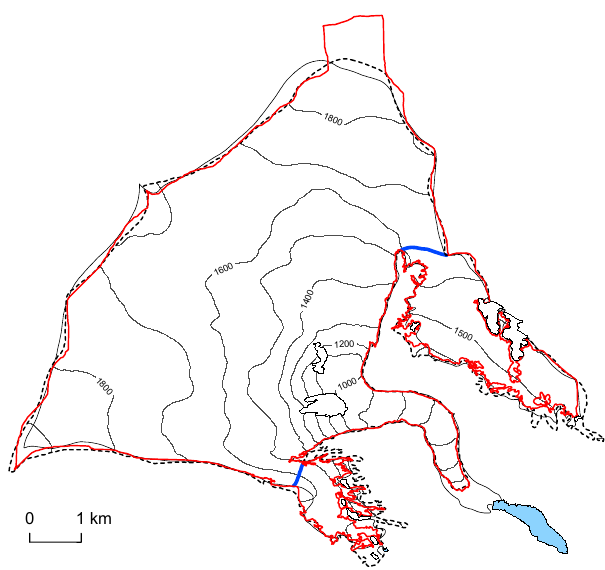
Figure 4. The hydrological basins of Nigardsbreen. The basin is derived from the 2013 mapping in red; the dotted line shows the 1984 extent and basin; the black solid line shows the 1964 extent. The glaciological divides used in the first years are marked in blue. Elevation contours are 100m derived from the 2013 DTM. Lake Nigardsbrevatn is shaded in